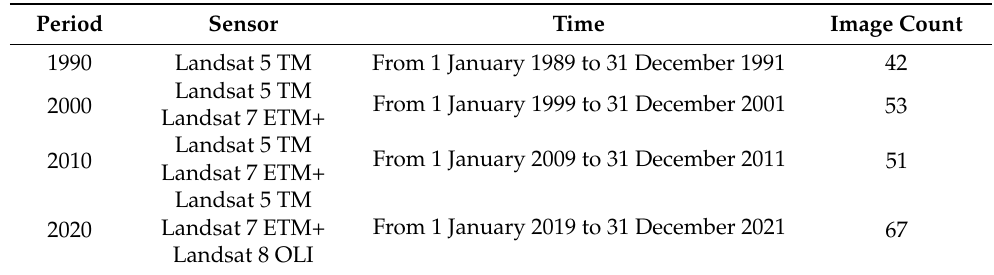
Table 1. Properties of remote sensing selected used in this study. Period Sensor Time Image Count